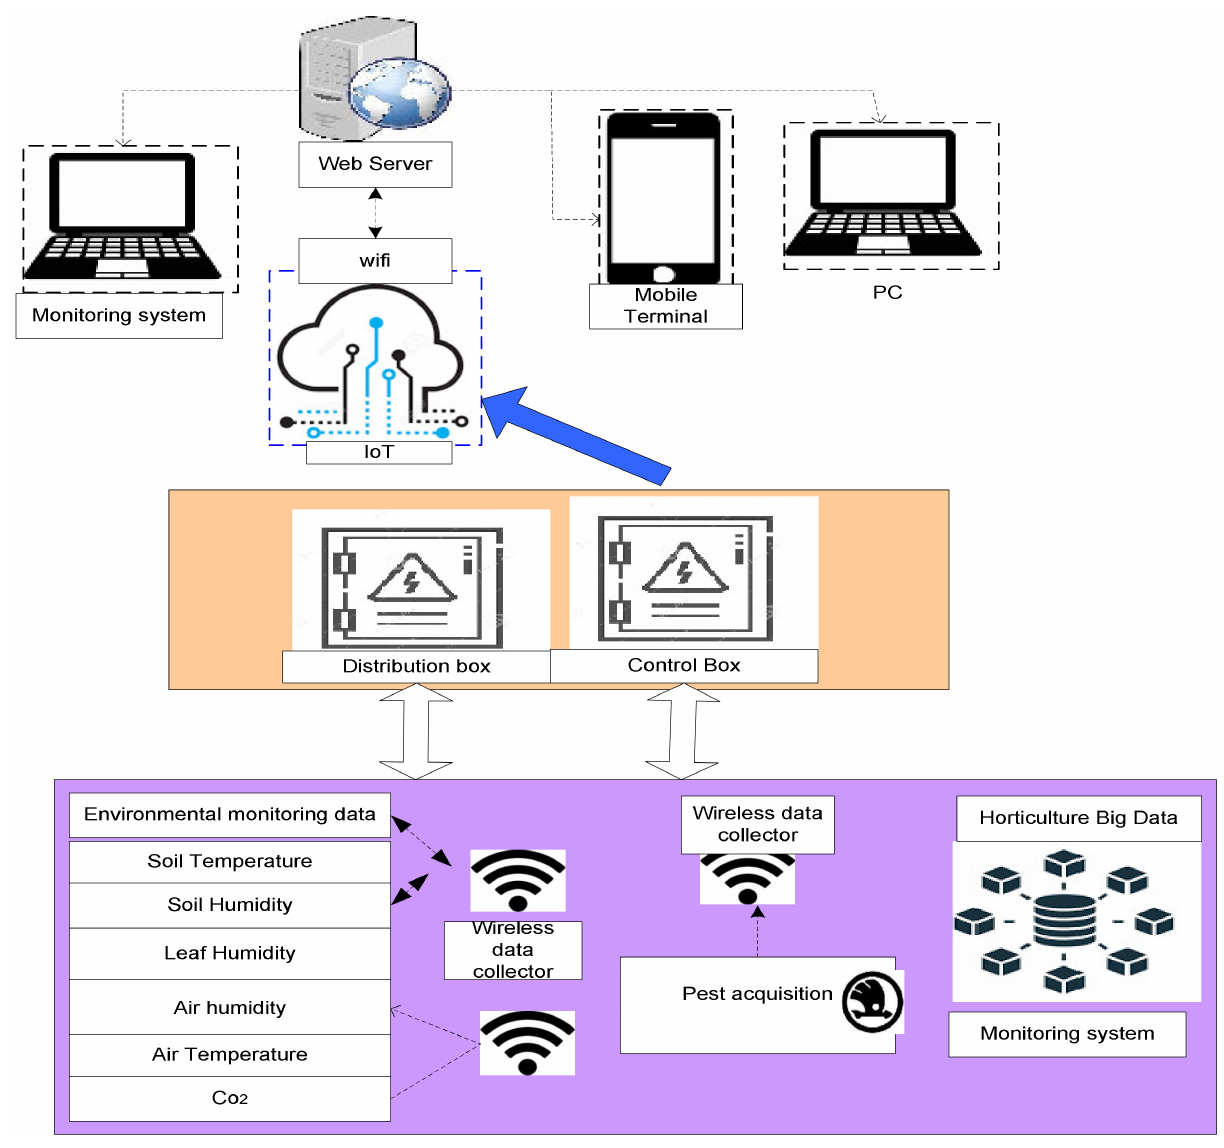
Figure 6. Big-data overview in